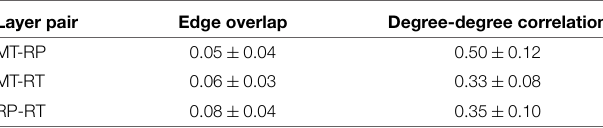
TABLE 3 | Number of nodes and edges of the network corresponding to each event considered in this study. Layer pair Edge overlap Degree-degree correlation